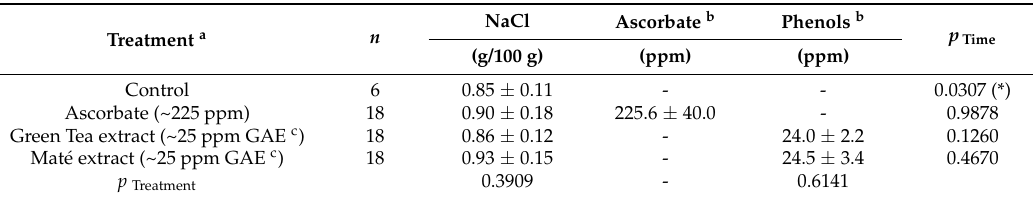
Table 1. Concentration of NaCl and calculated levels of ascorbate and phenols compounds in brine-injected pork chops.